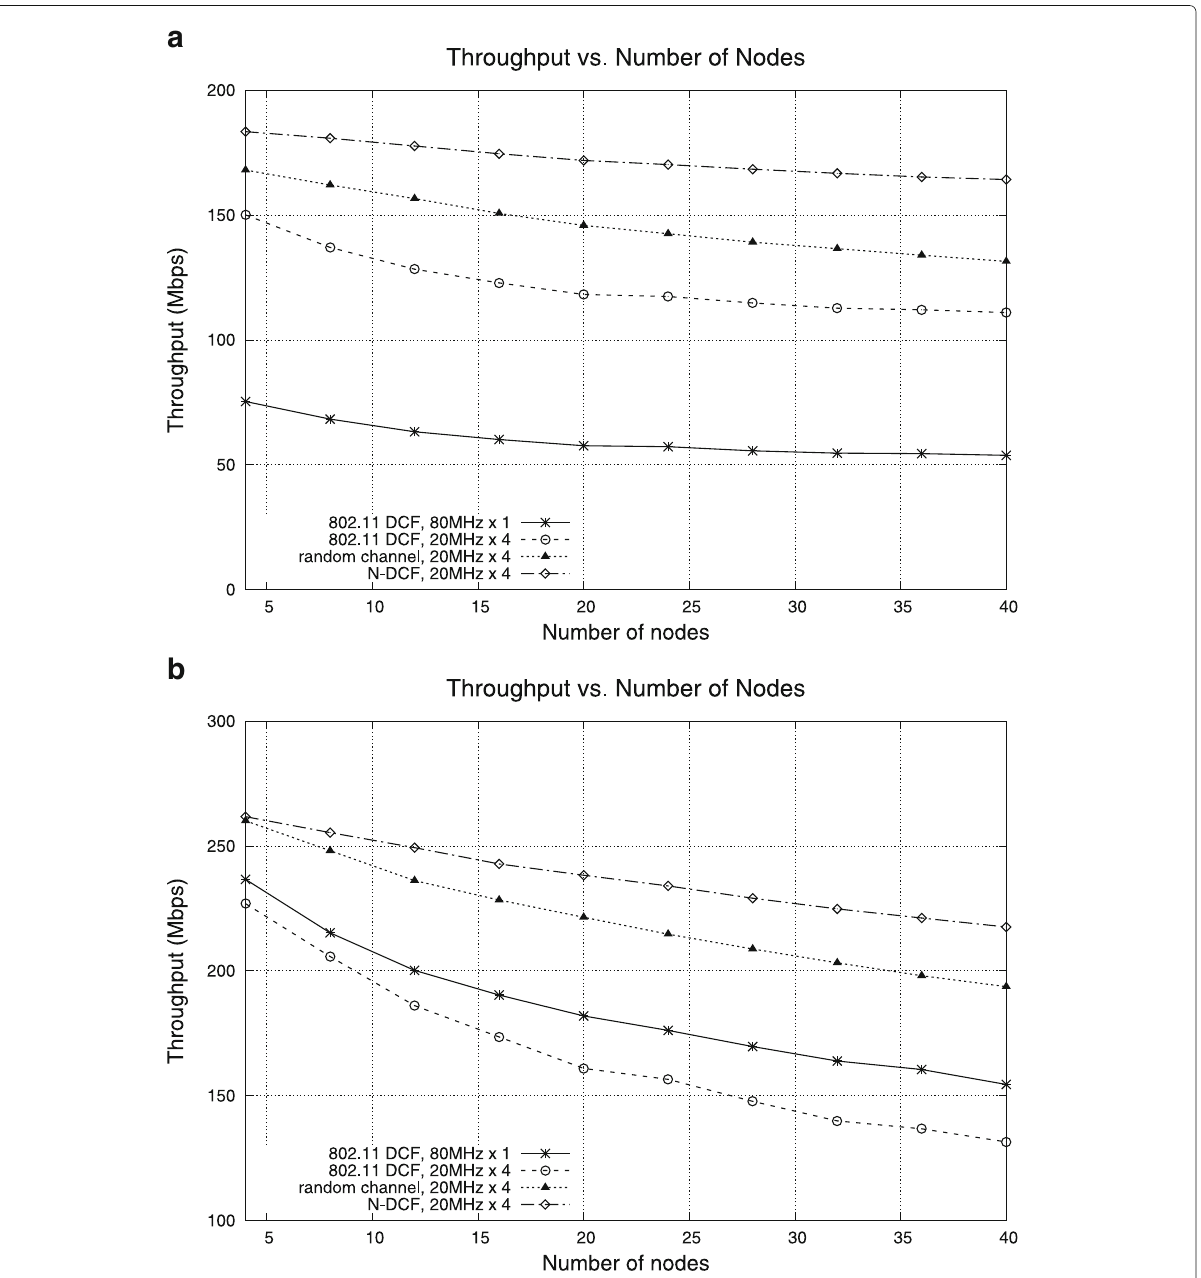
Fig. 16 Average throughput varying number of nodes for an ad hoc network. a A-MPDU size = 3000 bytes. b A-MPDU size = 65,535 bytes